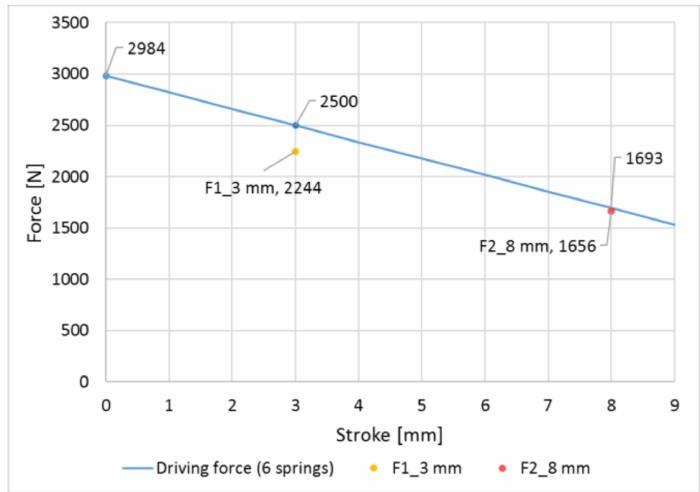
Figure 27. Mechanical Press delivered force during the Vault’s